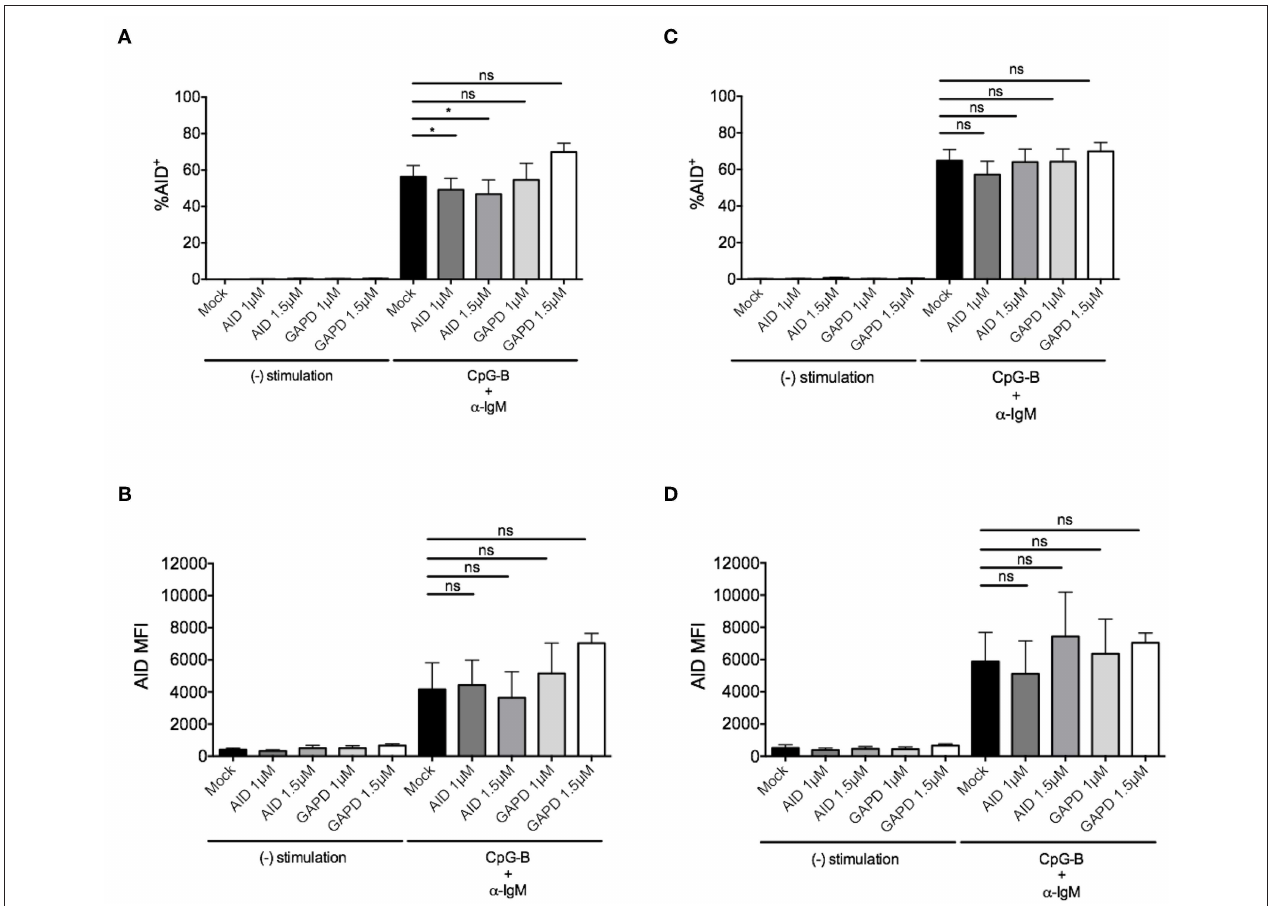
FIGURE 4 | Efficiency of AID knockdown in primary naïve human B cells is marginal at 48 and 72h post-nucleofection. Isolated naïve B cells were stimulated with anti-IgM + CpG-B after single nucleofection protocol with AID or GAPD siRNA (1 or 1.5 µ M). (A) % AID + CD19 + IgD + B cells is shown at 48h post-stimulation. (B) AID MFI is shown at same time point as (A) . (C) Same as (A) except % AID + CD19 + IgD + B cells is shown 72h post-stimulation. (D) AID MFI is shown at same time point as (C) . Bars represent mean ± SEM ( n = 4). Paired t -test for significance was performed (* p <